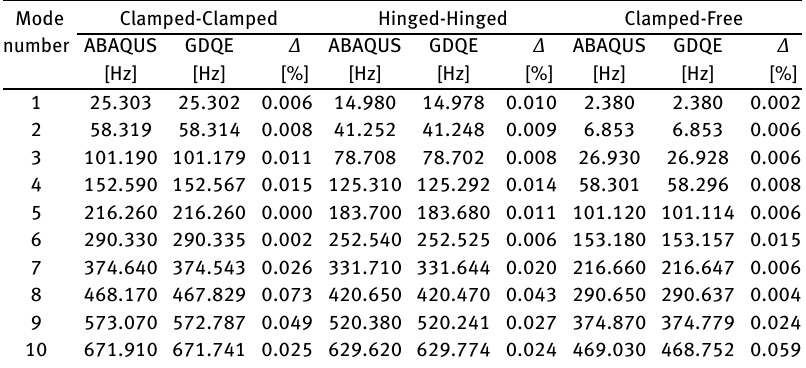
Table 4: Comparison between the ABAQUS solution and the current in-house code values for the first 10 natural frequencies for undamaged constant cross-section parabolic arches.